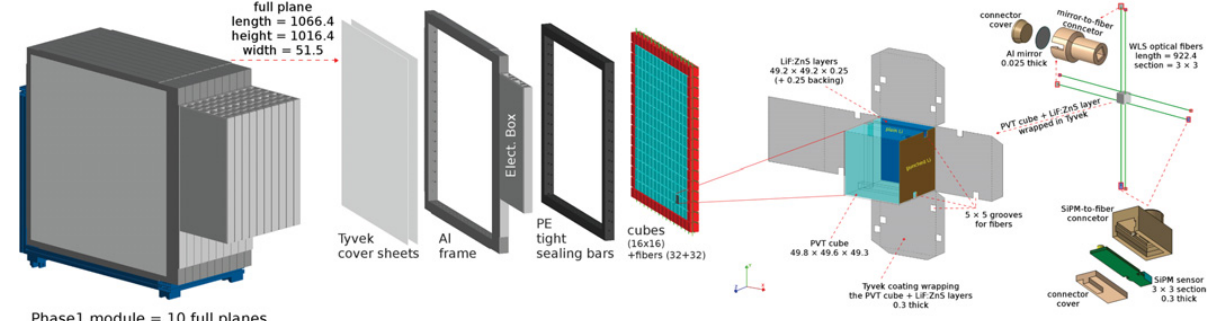
Figure 5. Diagram of a detector module, an exploded frame, cube assembly and fibre readout. Indicated sizes are in mm.